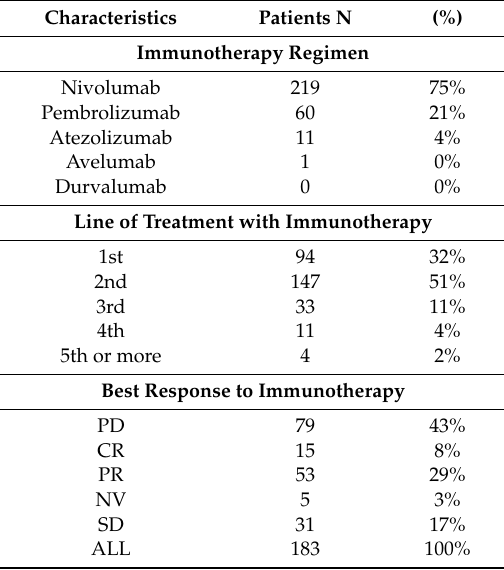
Table 2. Immunotherapy treatments and best response.